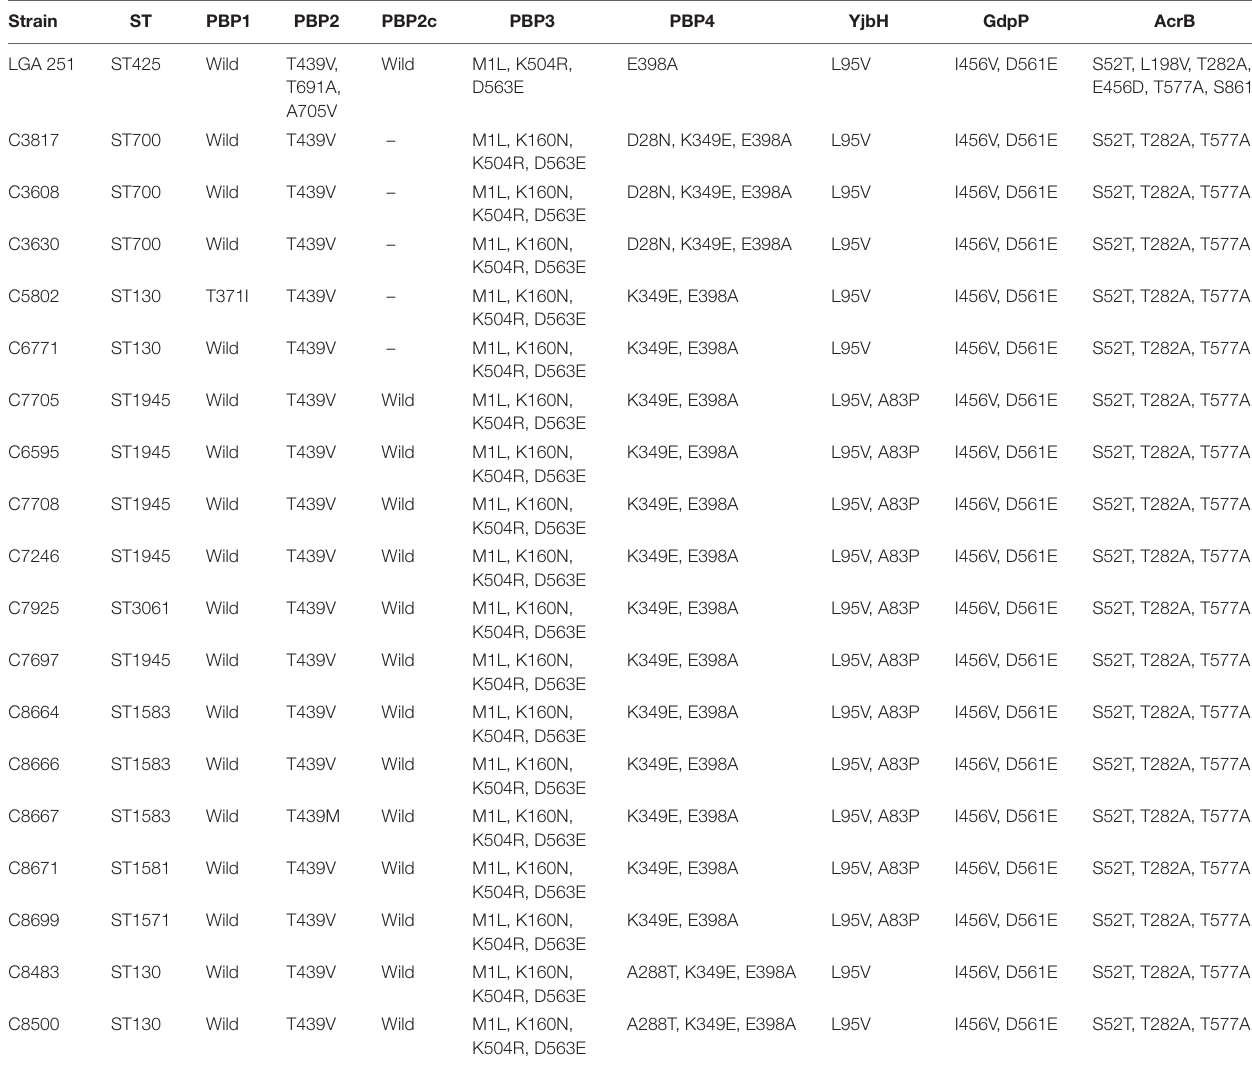
TABLE 3 | Identified amino acid changes in PBPs 1, 2, 2c, 3, 4, YjbH, GdpP, and AcrB proteins of the 18 S. aureus strains included in this study and also of MRSA LGA251 strain (MRSA LGA251 as used as reference strain for PBP2c and MSSA ATCC 25923 as reference strain for PBPs 1, 2, 3, 4, YjbH, GdpP, and AcrB protein